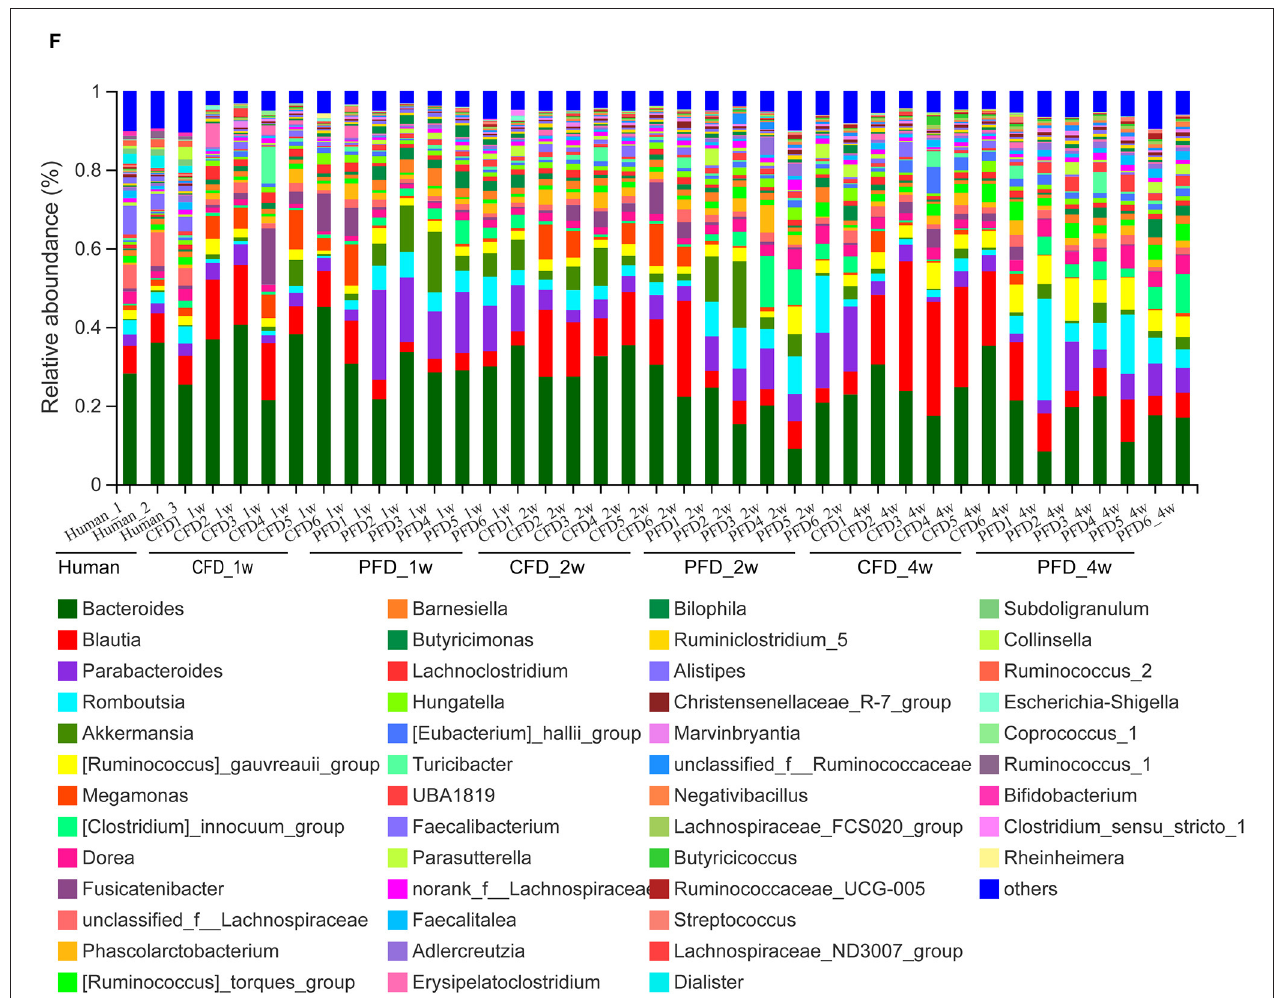
FIGURE 4 | Relative abundance of gut microbiota. (A) Microbiota composition at the phyla level at 1, 2, and 4 weeks. Relative abundance for (B) Firmicutes, (C) Bacteroidetes, (D) Verrucomicrobia, (E) Ratio of Firmicutes to Bacteroidetes, (F) Microbiota composition at the genus level at 1, 2, and 4 weeks. Taxa with an abundance < 1 % are included in “others”. The results were represented as mean ± SD. The statistical significance was determined using the One-way ANOVA and significant differences were indicated by p